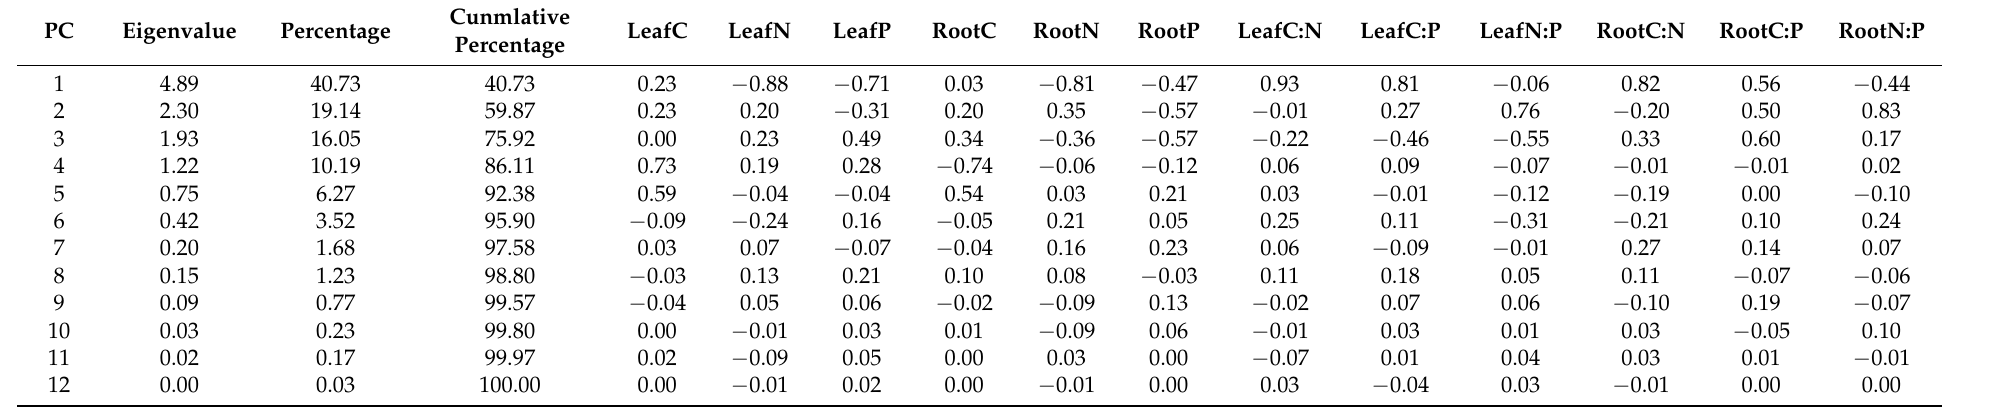
Table A3. The characteristic value and principal component contribution rate and its loads.